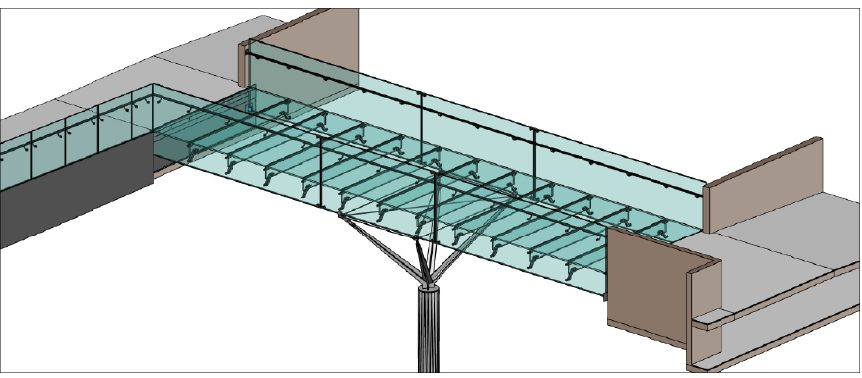
Figure 1: Glass Bridge – “Eaton Center”,